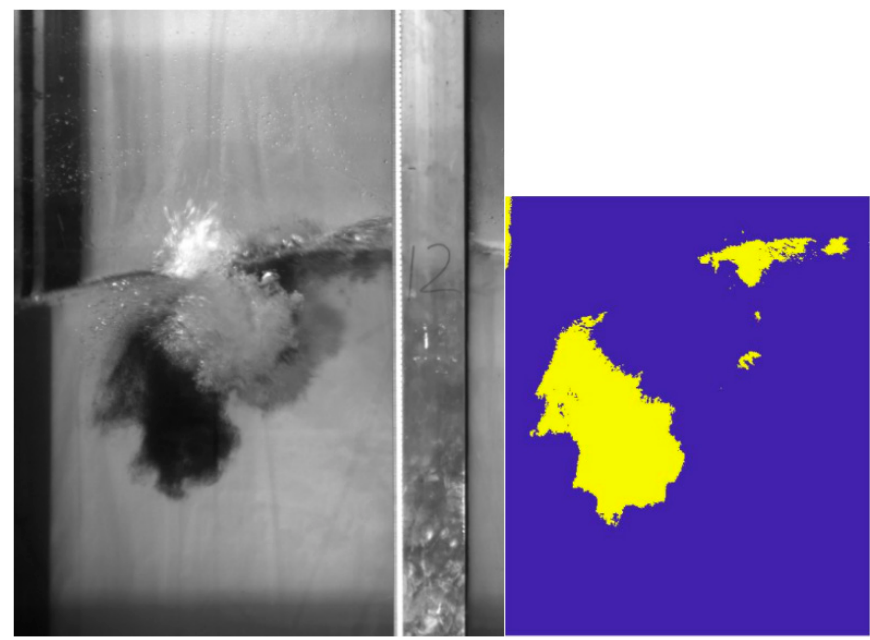
Figure 6. Spilled oil in the observation area was migrated by 15 cm breaking wave.